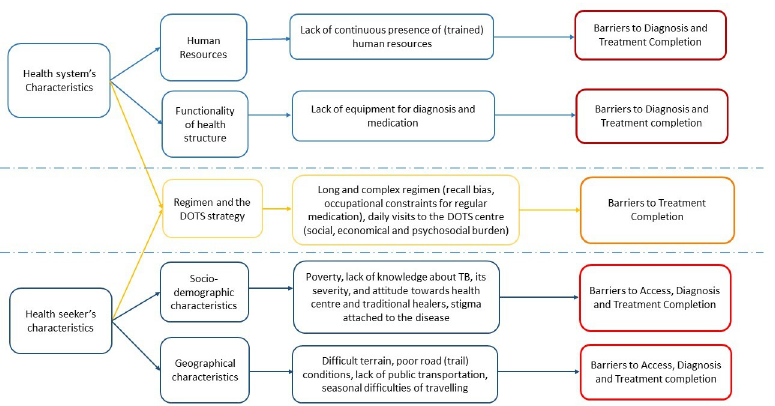
Fig 2. Factors affecting the barriers in access, diagnosis and treatment completion for tuberculosis